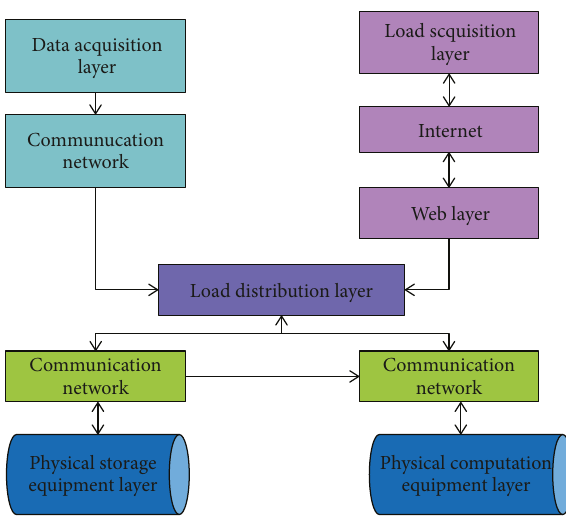
Figure 2: Architecture and technology implementation of the cloud computation platform.